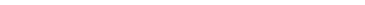
ZIP codes with relatively high levels of resilience and high JACOBS index values, which are most concentrated on the historic, high density north and northwest sides.